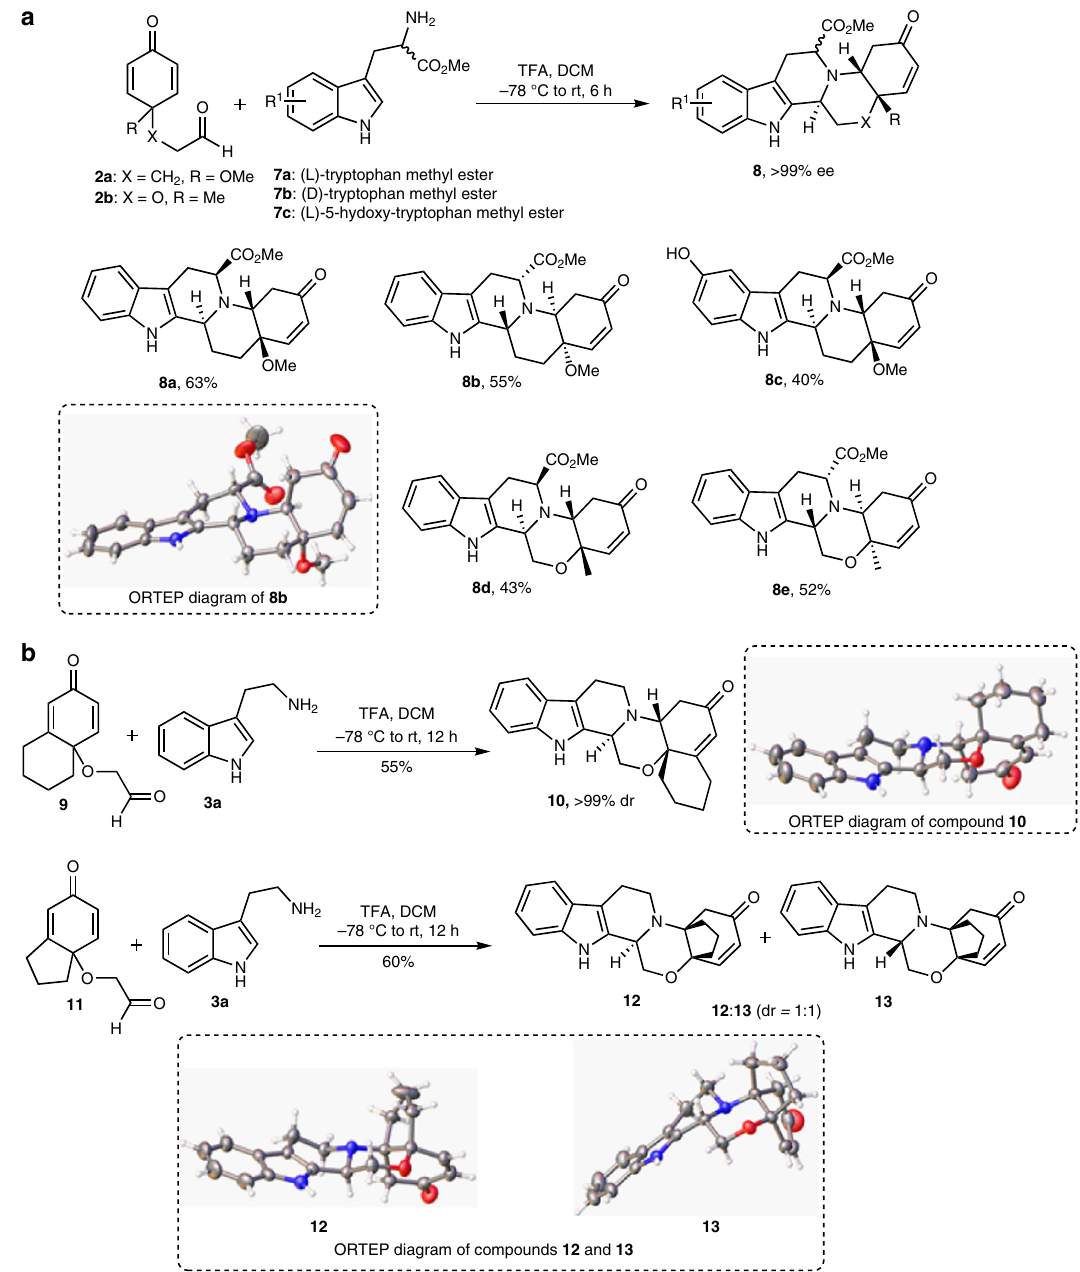
Fig. 4 Synthesis of skeletally diverse collections of octahydroindolo[2,3-a]quinolizines. a Asymmetric synthesis of polycyclic octahydroindolo[2,3-a] quinolizines. b Regioselective synthesis of